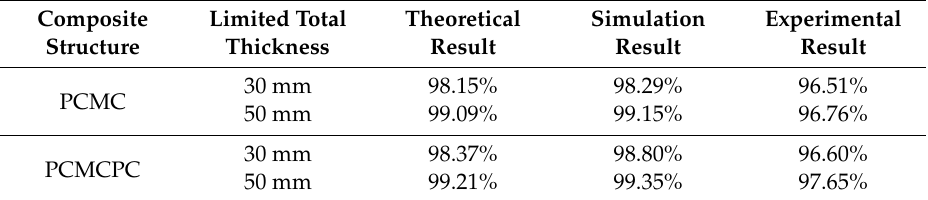
Table 6. Quantitative comparisons of average sound absorption coefficients in the frequency range (2000 Hz, 6000 Hz) in the theoretical result, the simulation result, and the experimental result.